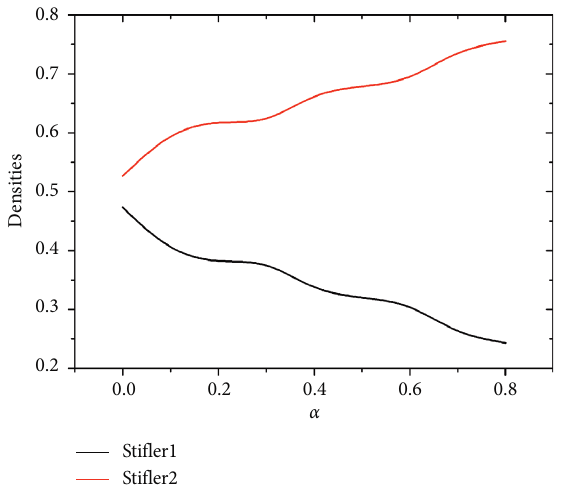
Figure 8: Density of stifler1 and stifler2 for different values of α at steady state.